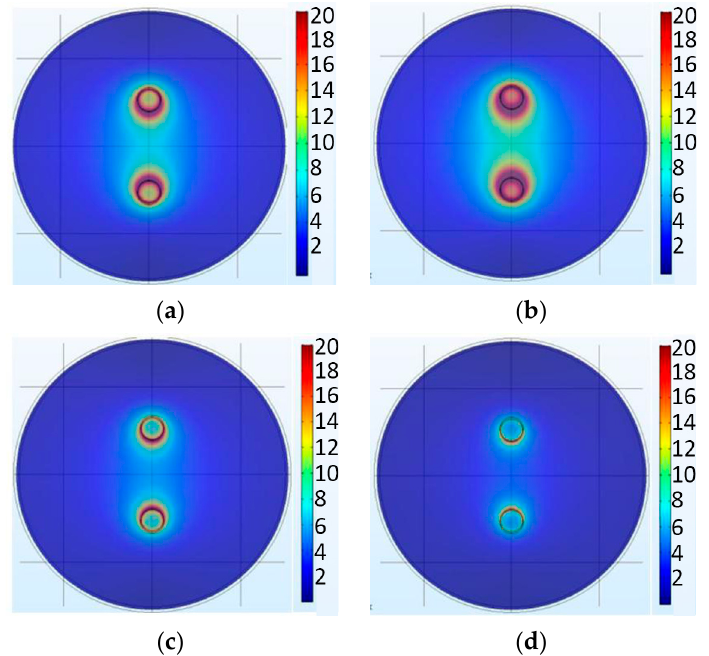
Figure 12. Distribution of EFS under different voltages. ( a ) EFS distribution (200 kV); ( b ) EFS distribution (160 kV); ( c ) EFS distribution (120 kV); ( d ) EFS distribution (80 kV).